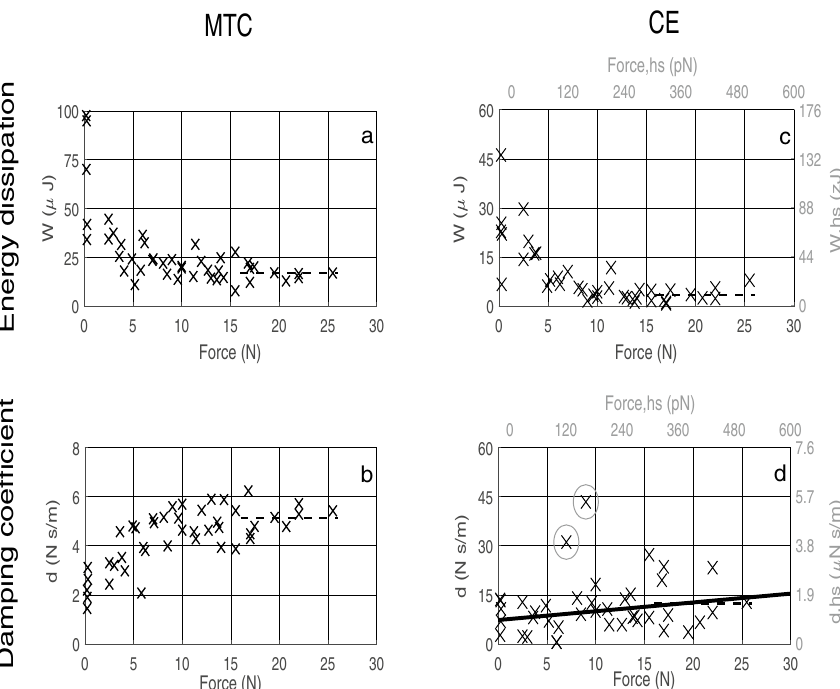
Figure 2. Energy dissipated and viscous damping coefficient of MTC and CE for all isometric and passive force states. ( a – d ) Data in each trial are calculated for one work-loop, i.e. one oscillation period that spans between TD and the instant when a COM returns closest to zero for the second time. See Fig. 3 for an example of one work-loop in a specific trial. For ( a – d ), the dashed, black line is the mean value of all data points > 16N : 17 µ J , 5.1Ns m − 1 , 3.5 µ J | 10.4 zJ and 12.5N s m − 1 | 1.6 µ N s m − 1 , respectively. ( a ) The energy dissipated by the MTC due to internal material friction. ( b ) The viscous damping coefficient calculated for MTC. ( c ) The energy dissipated by the CE, with the right and upper axes giving the work (Eq. 4) and isometric force (Eq. 3) values per half-sarcomere, respectively. ( d ) The viscous damping coefficient calculated for the CE, with the right and upper axes giving the damping coefficient (Eq. 5) and isometric force (Eq. 3) values per half-sarcomere, respectively. Due to the indistinct trend in ( d ), a linear fit was added. In ( d ), the circles indicate data that were considered outliers and excluded from the